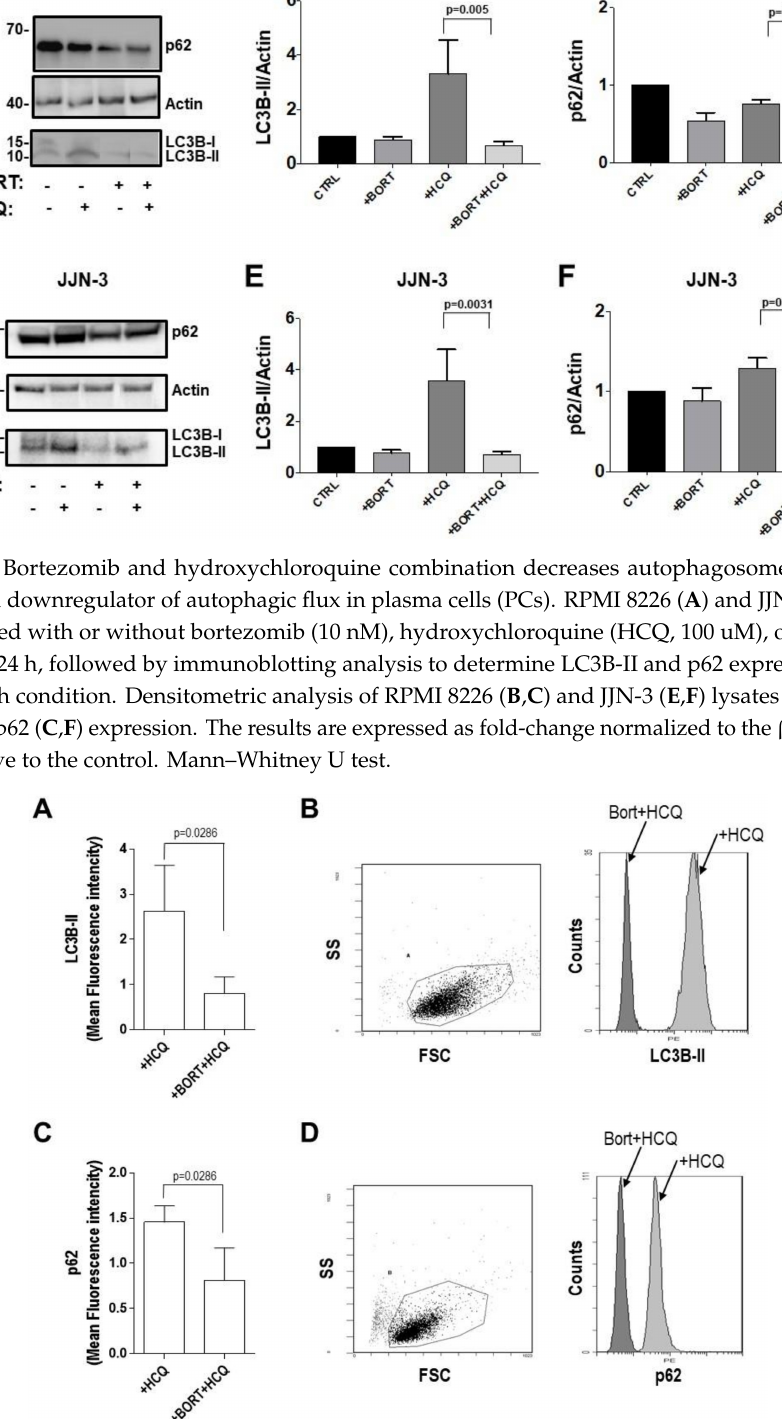
Figure 3. Bortezomib and hydroxychloroquine combination downregulates the autophagic flux in plasma cells (PCs). Changes in LC3B-II and p62 levels upon treatment with hydroxychloroquine (HCQ, 100 uM) alone or both bortezomib (10 nM) and HCQ for 24 h, determined by flow cytometry. Mean Fluorescence intensity ( A , C ) and representative plots ( B , D ) of primary plasma cells isolated from MM patients ( n = 6). Mann–Whitney U